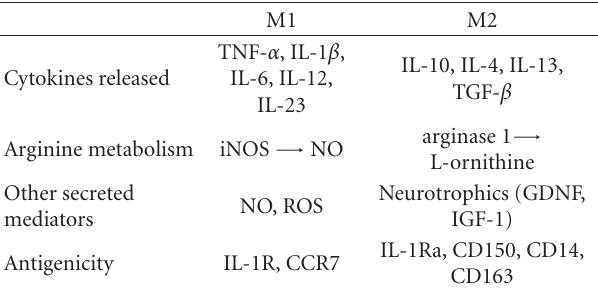
Table 1: Macrophage activation programs can be distinguished by the associated release of cytokines, arginine metabolism, secreted release of mediators, and antigenicity.